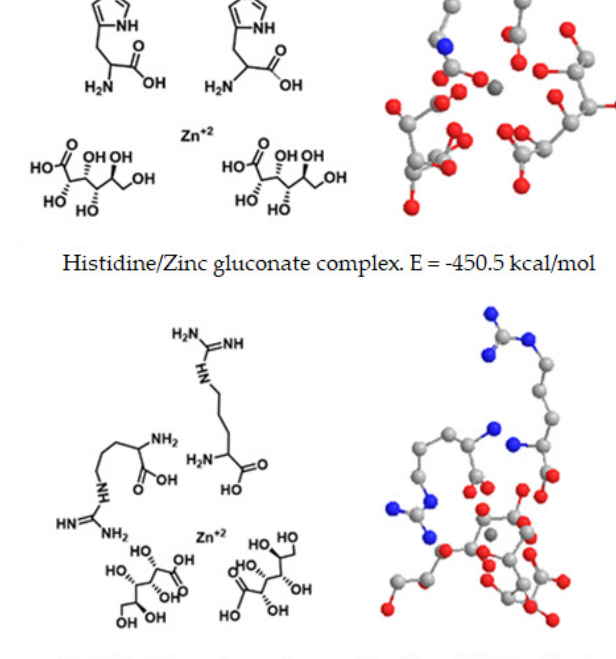
Figure 8. Energy content and most favorable spatial orientation of zinc gluconate complexes with proteinogenic amino acids (phenylalanine, tryptophan, histidine and arginine). Light grey balls represent carbon atoms. Blue balls represent nitrogen atoms. Non linked dark grey balls represent zinc cations. Red balls represent oxygen